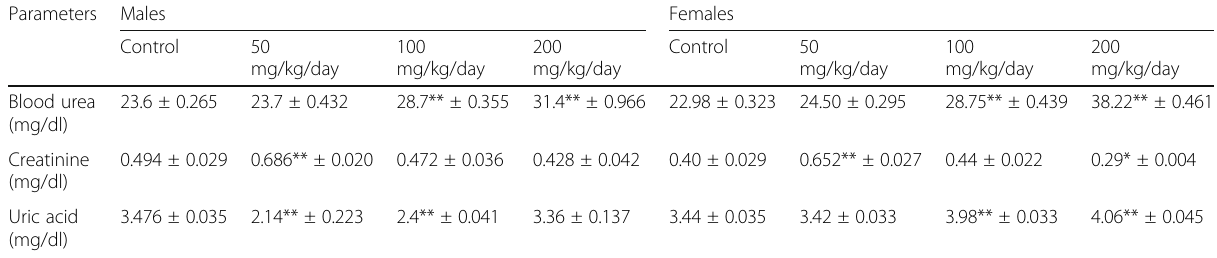
Table 5 Effect of different test doses of product on blood urea, creatinine and uric acid in male and female rats Parameters